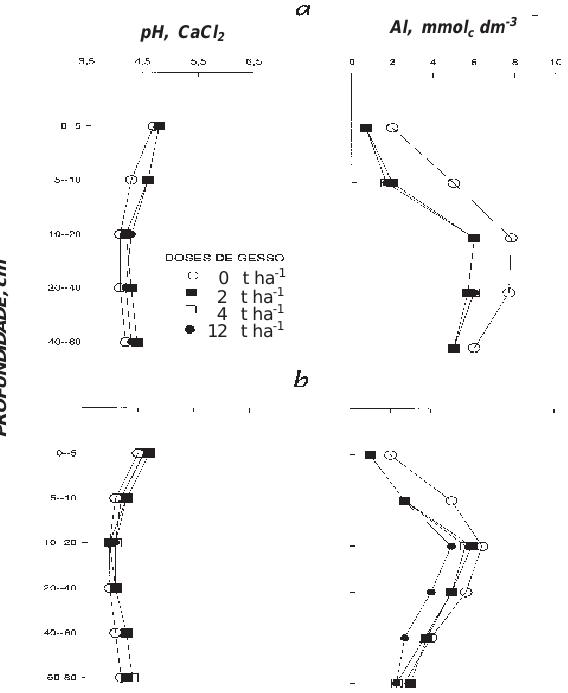
Figura 2. Efeito de doses de gesso nos valores de pH e teores de Al trocável do solo, em diferentes profundidades, após 8(a) e 24(b) meses da aplicação na superfície do solo. Média de 3